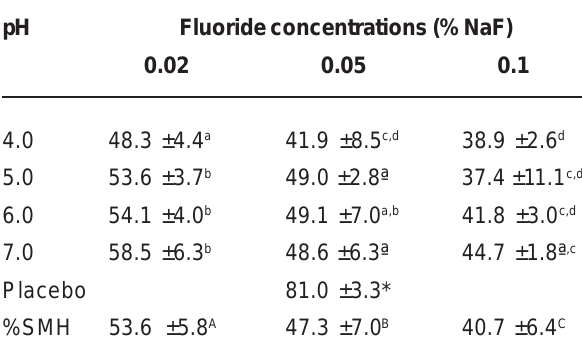
Means followed by distinct letters are statistically different (p<0.05). Mean followed by asterisk is statistically different to others groups (p<0.05). Capital letters show difference related to the effect of the concentration of